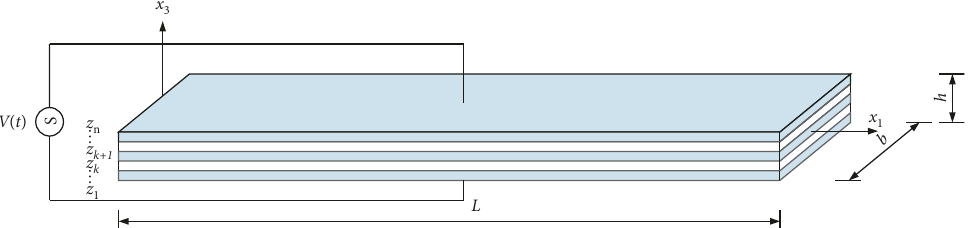
Figure 1: FGPM beams: Cartesian coordinate system and geometric parameters: length ( L ), width ( b ), and height ( h